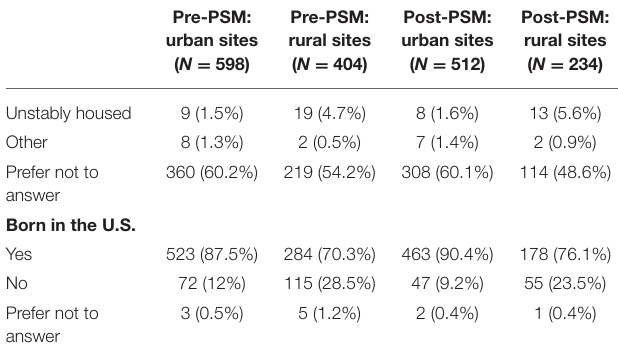
TABLE 2 | Demographics of the sample before and after propensity score